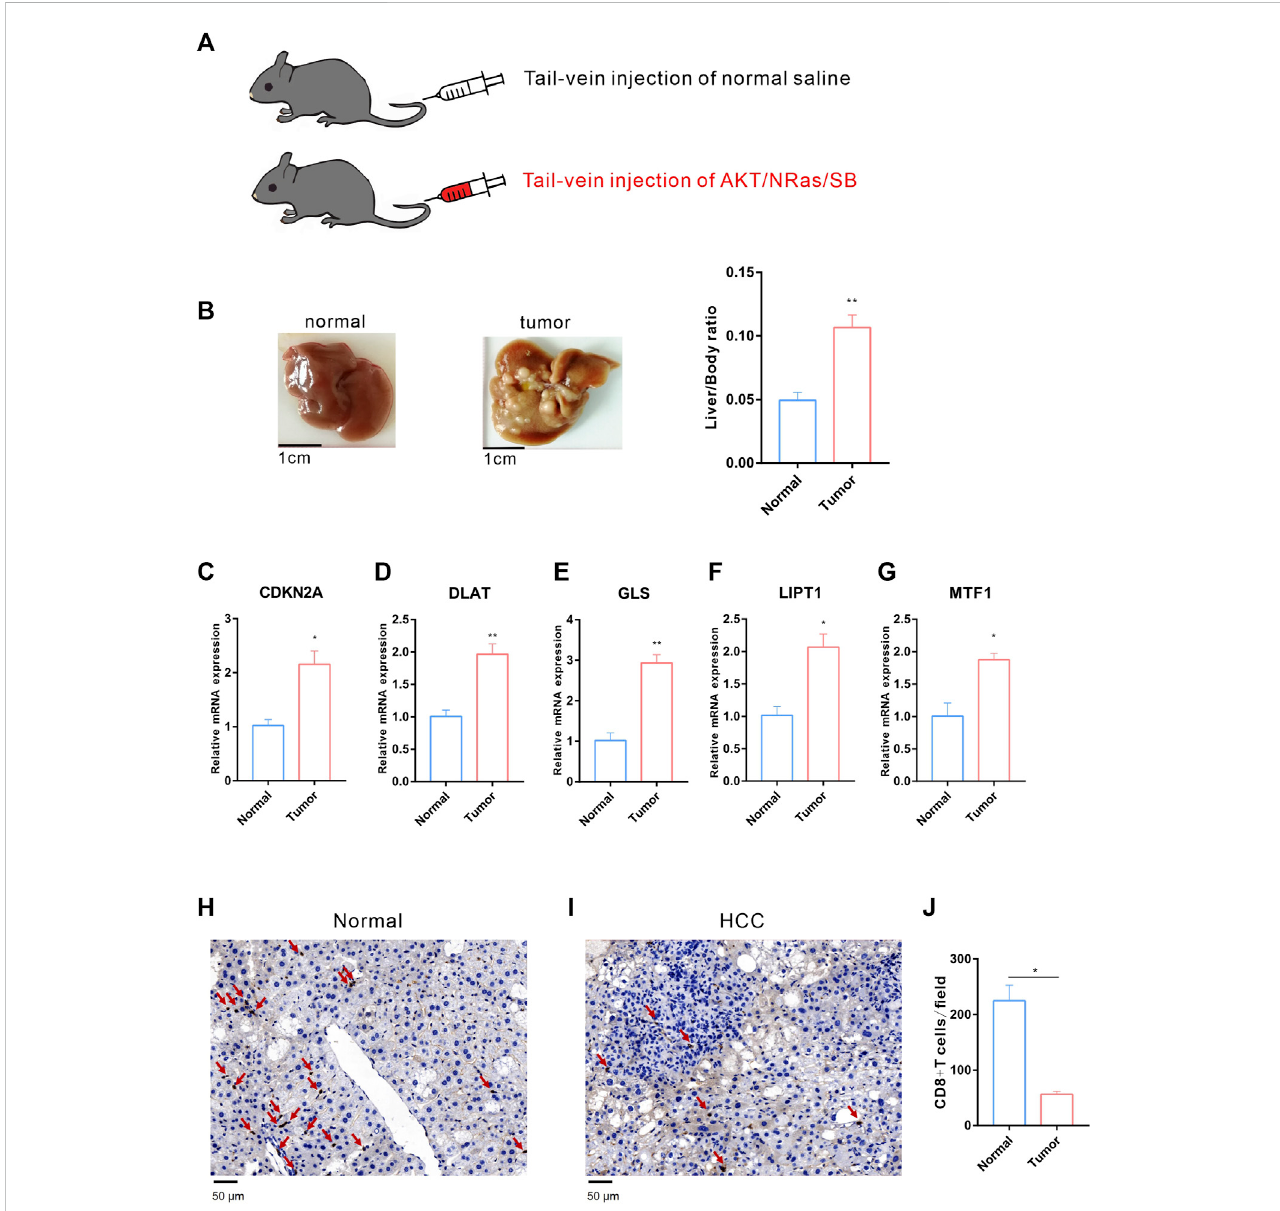
FIGURE 11 Validation of the expression of the fi ve prognostic CRGs in vivo HCC mouse model. (A) HCC mouse model diagram: C57BL/6 J male mice were hydrodynamicinjectedwithnormalsalineorAKT/NRas/SBplasmids,respectively. (B) Representativemouselivertissuesofnormal(left)andHCC(middle)and liver/body ratio between two groups (right). (C – G) The mRNA expression of CDKN2A, DLAT, GLS, LIPT1 and MTF1 in normal and HCC liver. (H – I) Immunohistochemistry (IHC) staining of CD8 between normal (H) and HCC (I) liver tissues. (J) The statistical analysis of CD8 + T-cell in fi led between normal and HCC